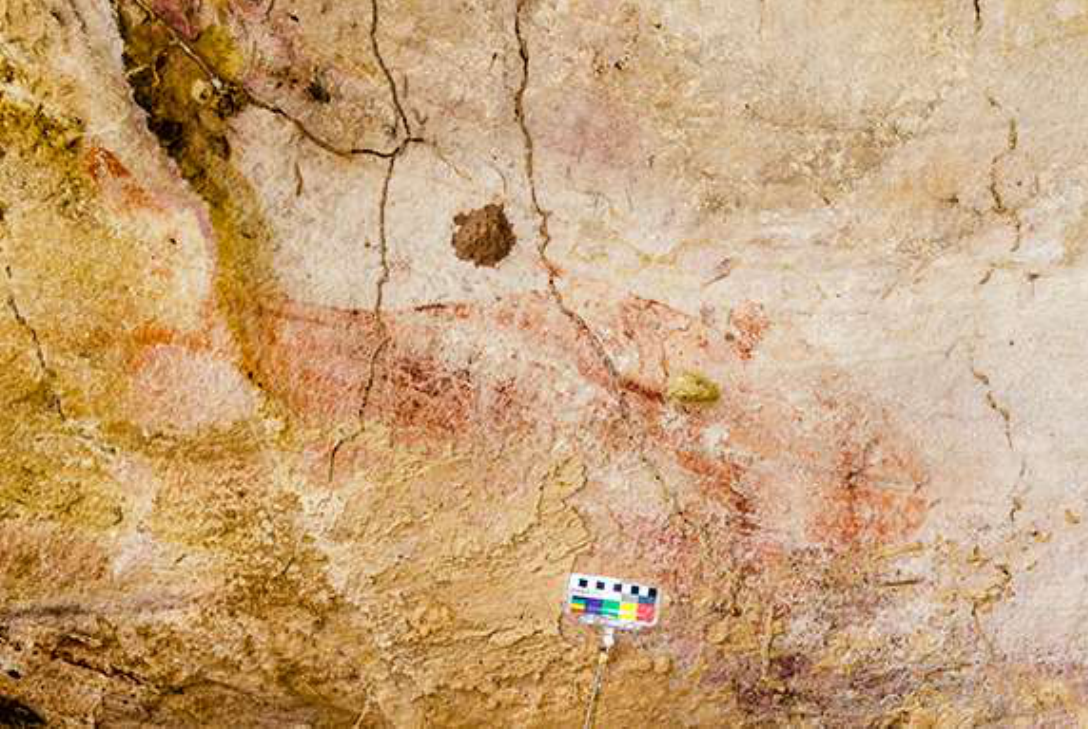
Figure 3. The rock art from Poeung Komnou in Siem Reap province, part of a series of newly discovered sites found in the Phnom Kulen area. Photo: Noel H.